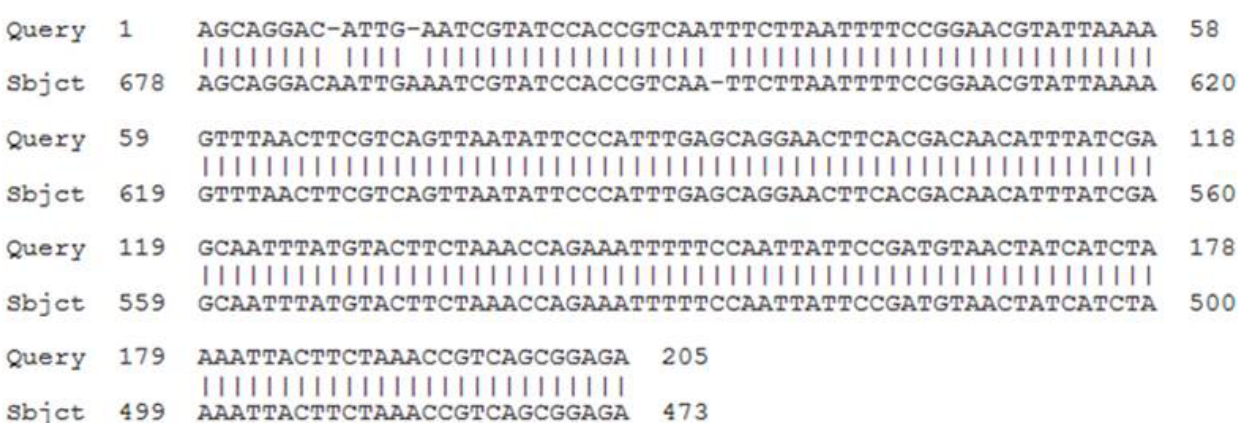
Figure 5. Comparative genomic sequence of SRBSDV between Shidian and Shaxian.